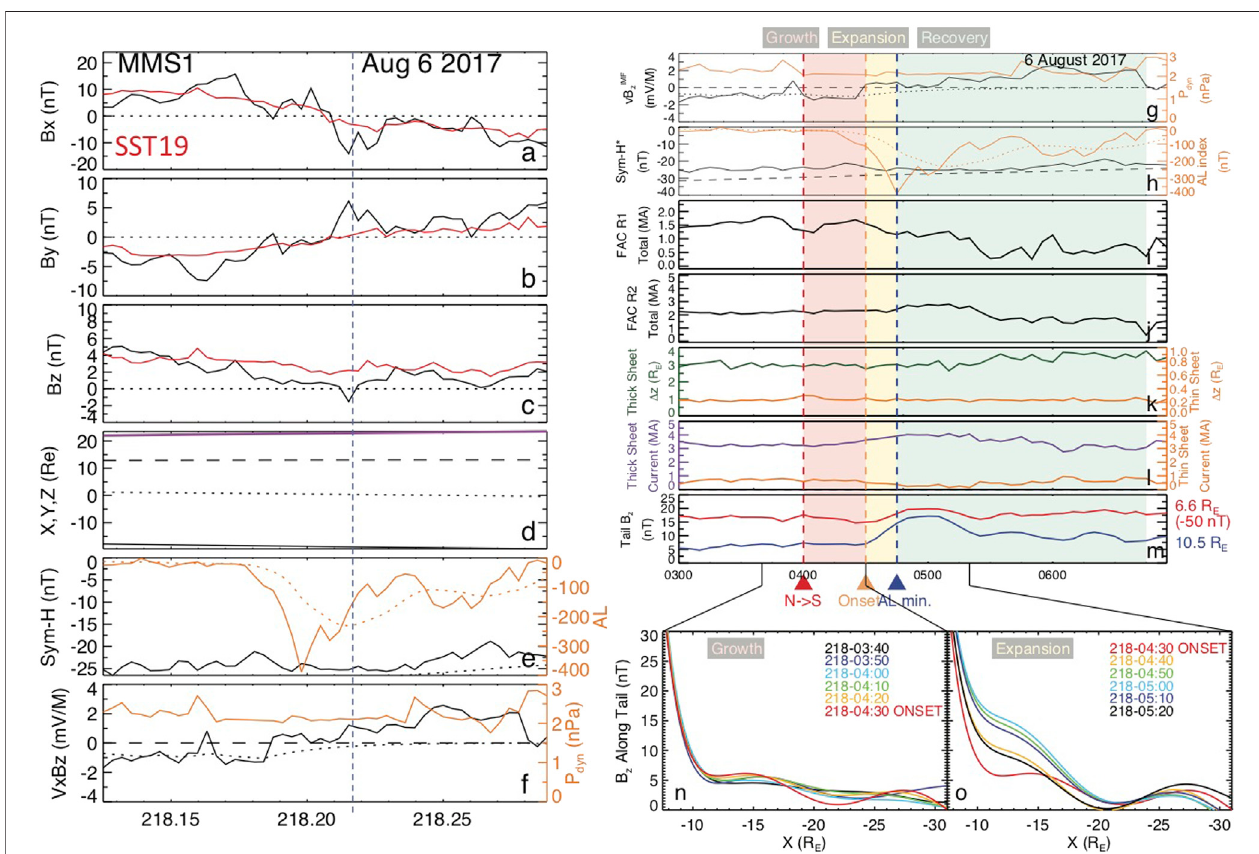
FIGURE 5 | Validation results (using MMS1 data with 5-min cadence) and analysis of the 6 August 2017 substorm. Panels (A – C) show observed (black lines) and reconstructed (red lines) values of the GSM magnetic fi eld components, (D) the MMS1 probe ephemeris (X, Y, Z and the radial distance R (black solid, dashed, dotted andpurplelines, (E) Sym − H * )(blackline)and AL (orangeline)indicesofstormandsubstormactivity,aswellas(f)thesolarwindelectric fi eldparameter vB IMF z (blackline) and solarwind dynamic pressure P dyn (orange line). Dottedlines inpanels (E, F) show thesmoothed valuesofindicesand solarwindelectric fi eldcorresponding to theirDM inputfunctions(2),(4)and(6).Themomentofthepossible X-linecrossingismarkedbytheverticaldashed line.Panels (G) and (H) repeatthesolarwind electric fi eld and dynamic pressure parameters as well as geomagnetic indices (dotted lines show the corresponding smoothed values) to guide the analysis. (I, J) The square root of the sum of the squared amplitude coef fi cients for the high and low-altitude parts of the FAC modules, respectively (labeled here as FAC R1 and FAC R2). (K) The equatorial CShalfthickness parameters D (green) and D TCS (orange). (L) The westward current from the thick CS module passing through the rectangle: − 16 R E ≤ X ≤ − 6 R E and − 5 R E ≤ Z ≤ 5 R E (deep violet) and the westward current from the TCS module passing through the rectangle: − 16 R E ≤ X ≤ − 6 R E and − 1 R E ≤ Z ≤ 1 R E (orange). (M) Total modeled B z fi eld sampled at r (cid:1) (− 6 . 6 R E , 0 , 0 ) in red and r (cid:1) (− 10 . 5 R E , 0 , 0 ) in blue. (N, O) Total modeled B z sampled along the line (− 31 R E ≤ X ≤ − 7 . 5 R E ) during the growth and expansion phases, respectively. The moment of time, when each B z -pro fi le was sampled, is speci fi ed by the corresponding colored text in the format “ DOY-hour-minute ”